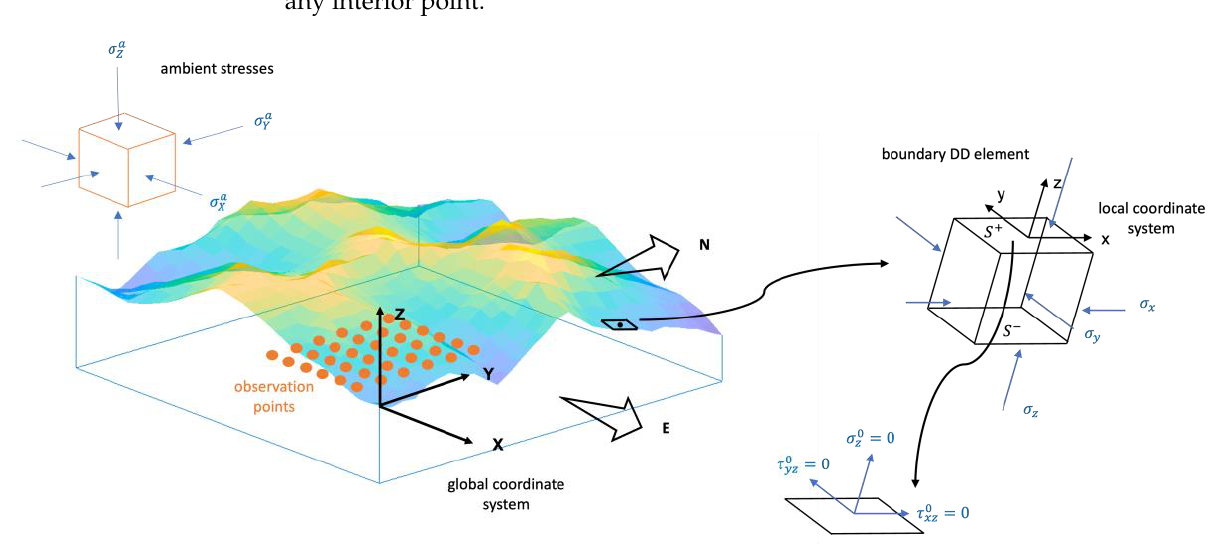
Figure 2. Schematic diagram of the basic configuration of a DDM model. The global DD plane and the domain are plotted on the left in global axes; an enlarged individual DD element on the topographic surface is plotted on the right in local axes. The traction-free condition on the exposed surface is visualized with the figure at the bottom for such a boundary DD element. Note that the DD element is not drawn to scale as its thickness is considered negligible compared to its lateral extent.